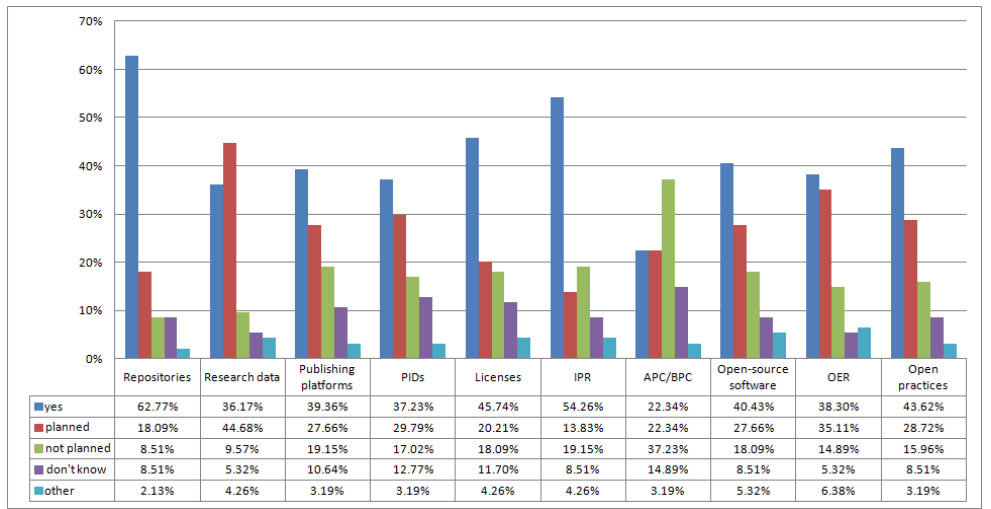
Figure 3. Training and support provided by libraries, e-infrastructures, research infrastructures and service providers (survey data).